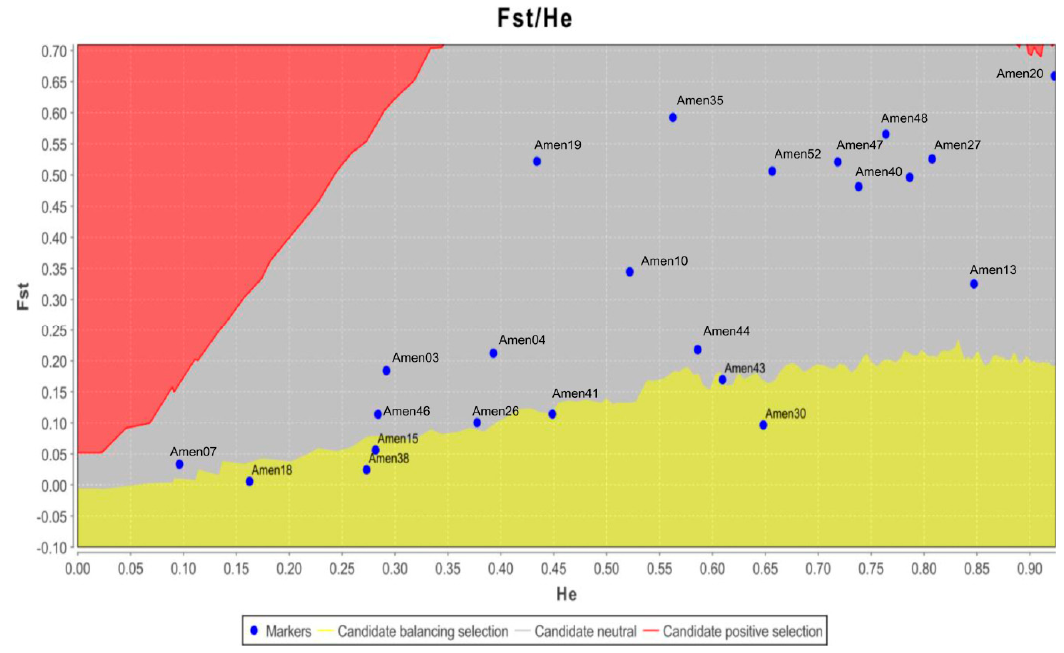
Figure 3. Assessment of outlier EST-SSR loci using LOSITAN software, which evaluated the expected distribution of the Wright inbreeding coefficient (F st ) and expected heterozygosity (H e ) by applying an island model of migration along with neutral markers. The five loci, Amen15, Amen18, Amen30, Amen38, and Amen43, were identified as outliers. Dots in the red and yellow areas represent candidate loci for positive or balanced selection.